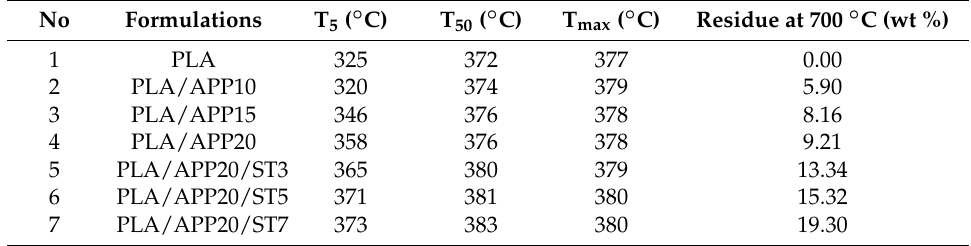
Figure 8. ( a ) Thermogravimetric analysis curves of pure PLA and PLA/APP composites. ( b ) Thermogravimetric analysis curves of pure PLA and PLA/APP/ST composites. Table 3. Thermogravimetric analysis of PLA/APP and PLA/APP/ST